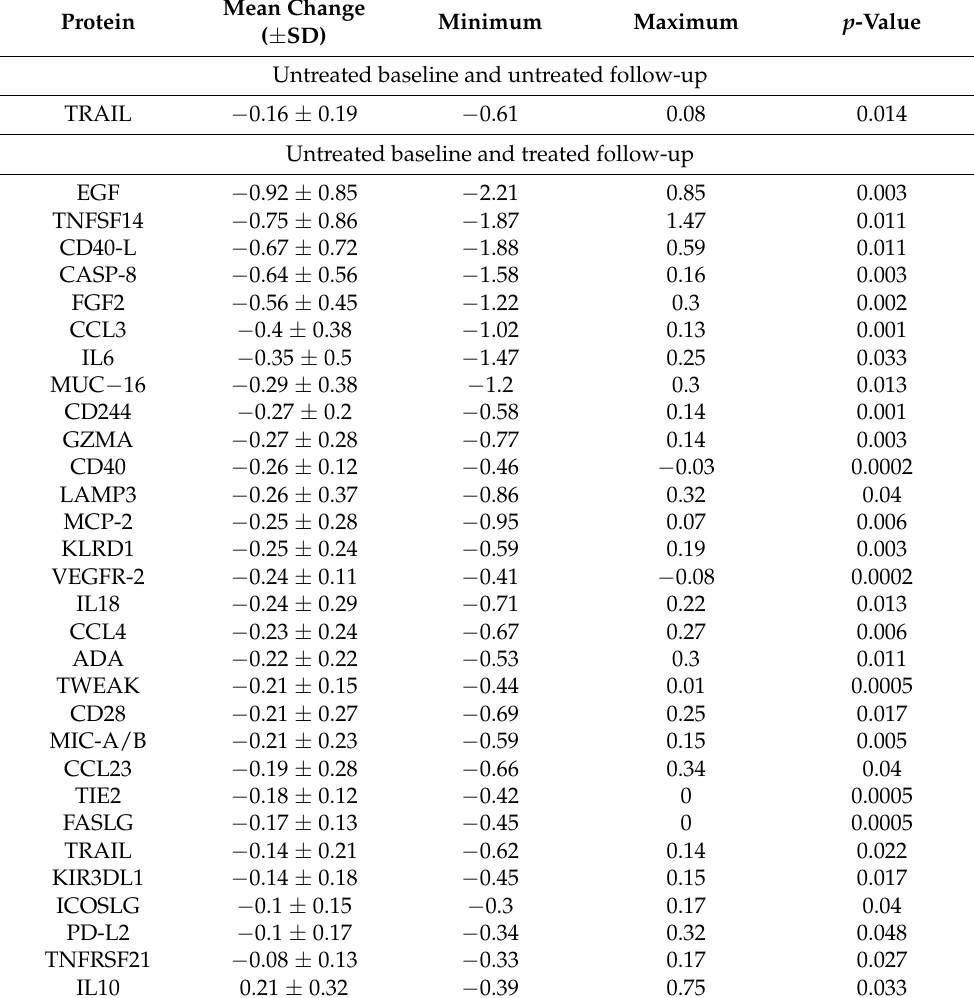
Table 7. Impact of treatment with antifibrotics on protein concentrations in serum from IPF patients. Patients were divided in three groups according to their treatment status at baseline and at follow-up. p -values calculated using Wilcoxon signed-rank